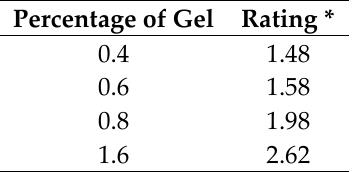
Table 3. Percentage of S. hispanica gel adequate for a drink according to consumers’